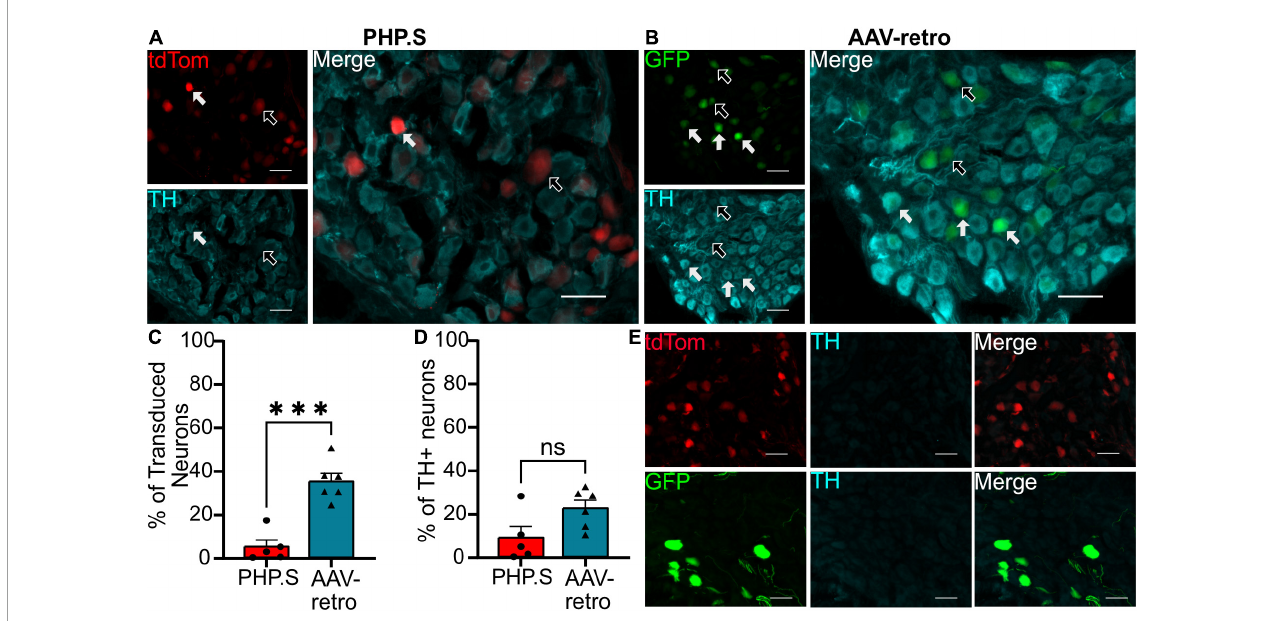
FIGURE9 Adeno-associated viruses (AAV)-retro shows tropism for sympathetic neurons over PHP.S in pelvic ganglia. (A) Representative images of tdTomato expression colocalizing with TH + neurons in pelvic ganglia from PHP.S-injected rats (scale bar, 50 µ m). (B) Representative images of GFP expression colocalizing with TH + neurons in pelvic ganglia from AAV-retro-injected rats (scale bar, 50 µ m). (C) Percent of transduced neurons that were TH + ( ∗∗∗ p = 0.0002). (D) Percent of TH + neurons that were transduced ( p = 0.0536). (E) Images of pelvic ganglia from rats injected with PHP.S (top) or AAV-retro (bottom) with secondary antibody staining only in the corresponding fluorophore used for TH in experimental tissue. Statistics were performed using the student’s t -test to compare PHP.S ( n = 5) and AAV-retro ( n = 6). White arrows indicate neurons with colocalization; black arrow with a white outline indicates viral transduced without colocalization.